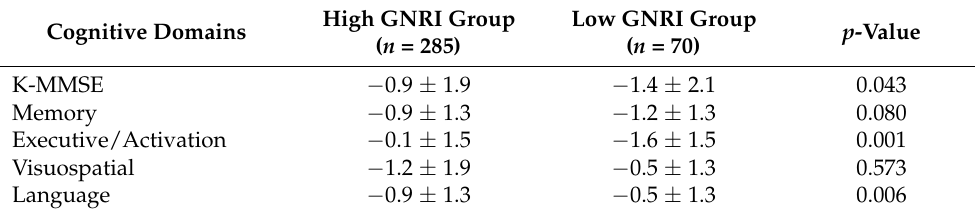
Table 2. Comparison of z-scores of K-MMSE and each cognitive domain. Cognitive Domains